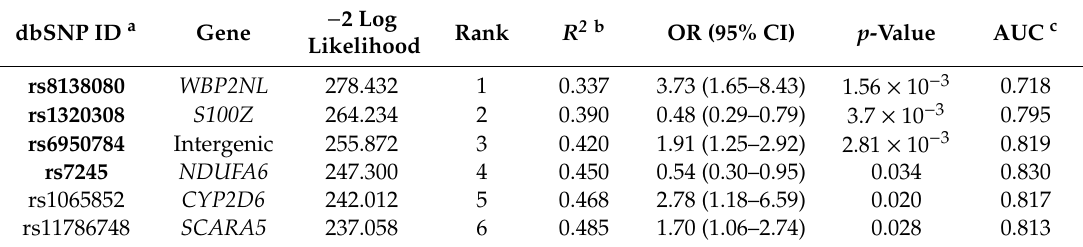
Table 4. Multivariate regression analysis considering a set of 15 SNPs, including two CYP2D6 variants (Approach